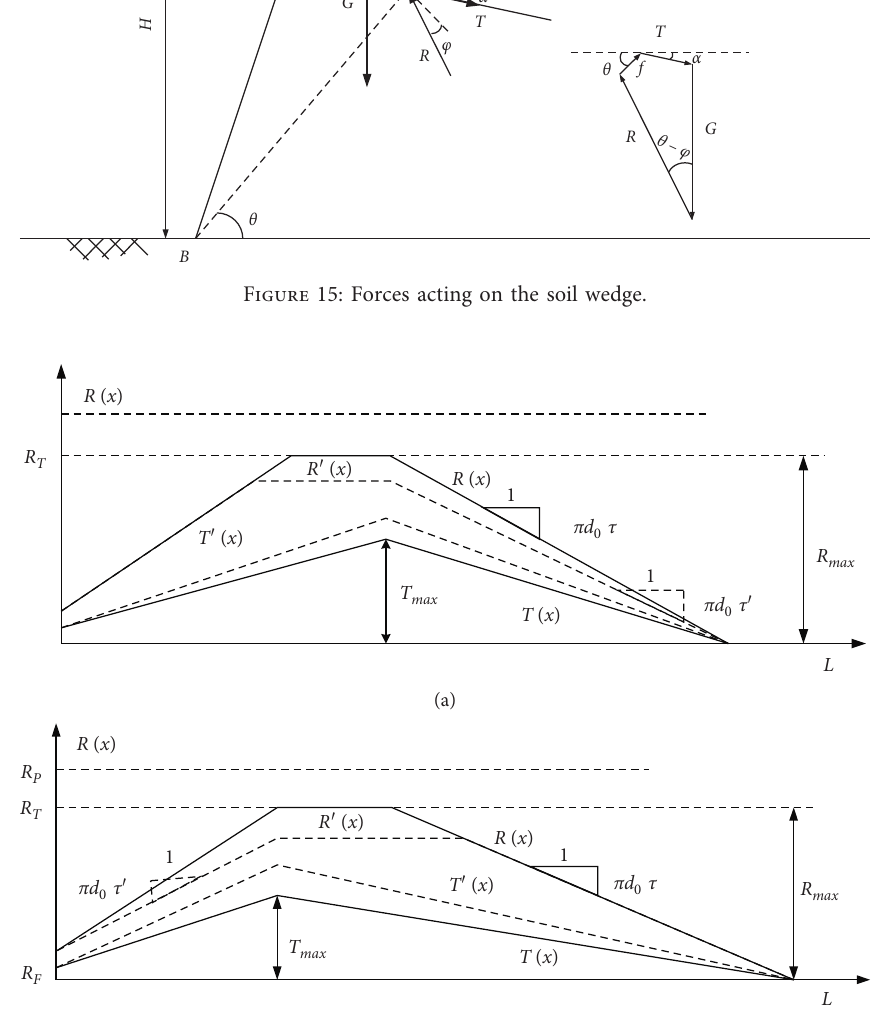
Figure 16: Variation of nail force and resistance with the variation of soil behavior. (a) Resistance is controlled by pullout failure of the stable soil mass. (b) Resistance is controlled by pullout failure of the unstable soil